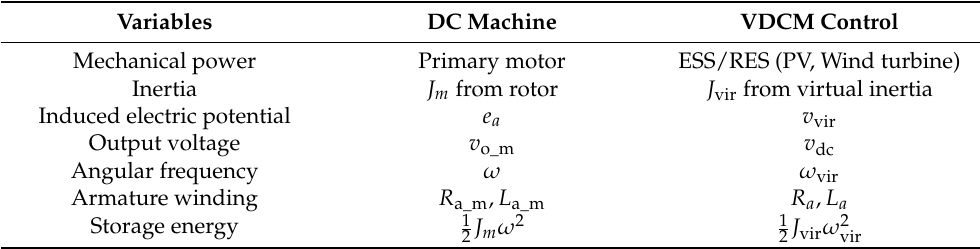
Table 2. Analogy between dc machine and VDCM